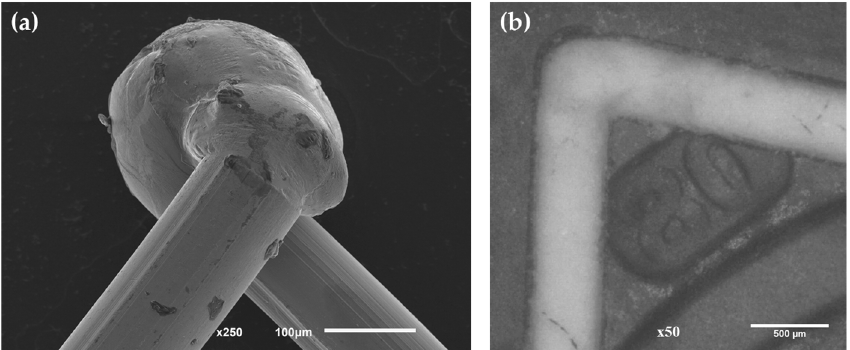
Figure 3. ( a ) SEM image of the laser-welded K-type thermocouple hot junction; ( b ) SEM image of the WC-Co cutting insert with the K-type embedded thermocouple.